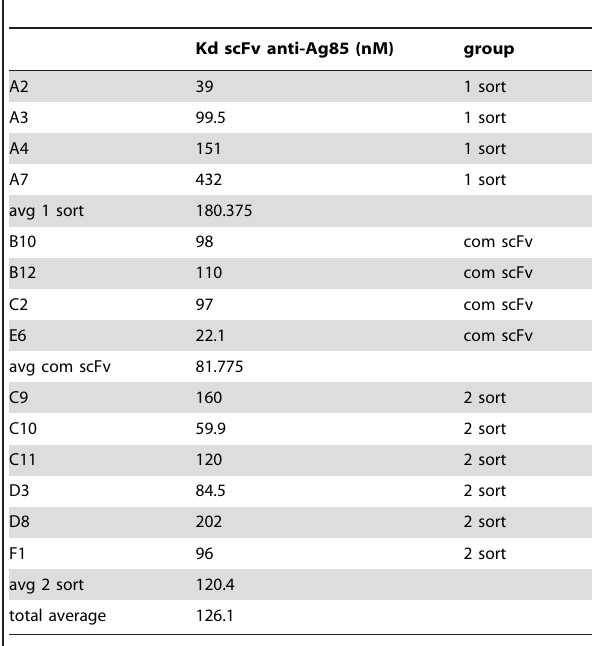
Table 2. Affinities of 14 antibodies determined directly on the surface of